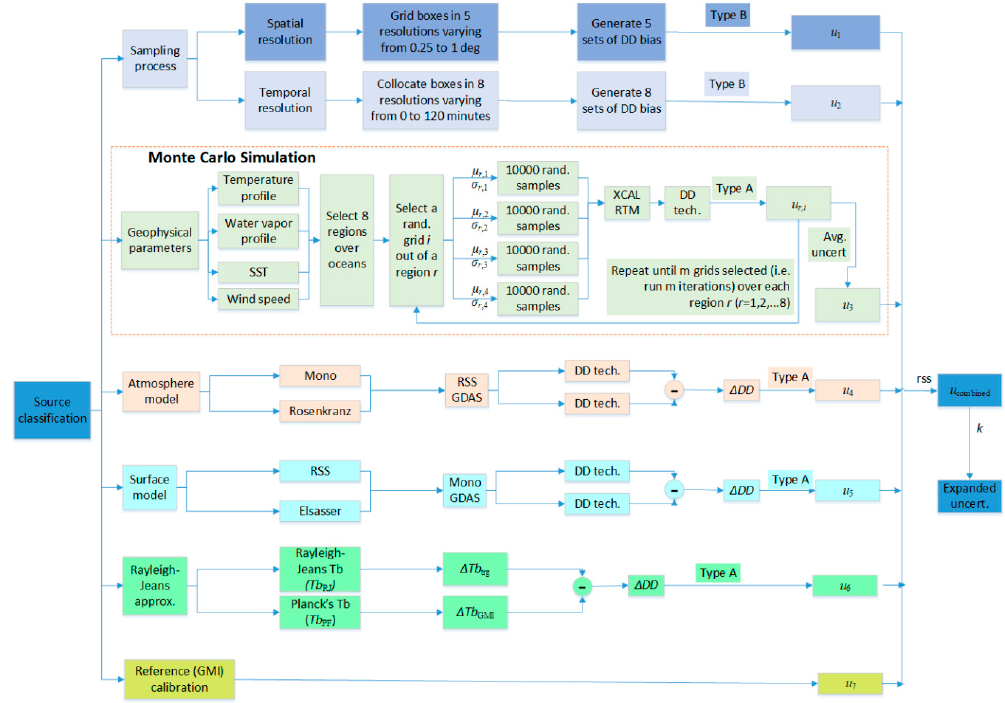
Figure 2. Diagram of uncertainty quantification model for six independent sources of radiometric uncertainty. The Monte Carlo simulation is highlighted by the pink dash-line box within which µ and σ are the bias and root mean square (rms) in the region r for the four geophysical parameters: temperature profile, water vapor profile, sea surface temperature (SST) and wind speed. ∆ Tb trg is the Tb deviation of Rayleigh–Jeans approximation from the Planck’s Law for a target (trg) radiometer. Detailed illustration was provided in the remainder of this section.